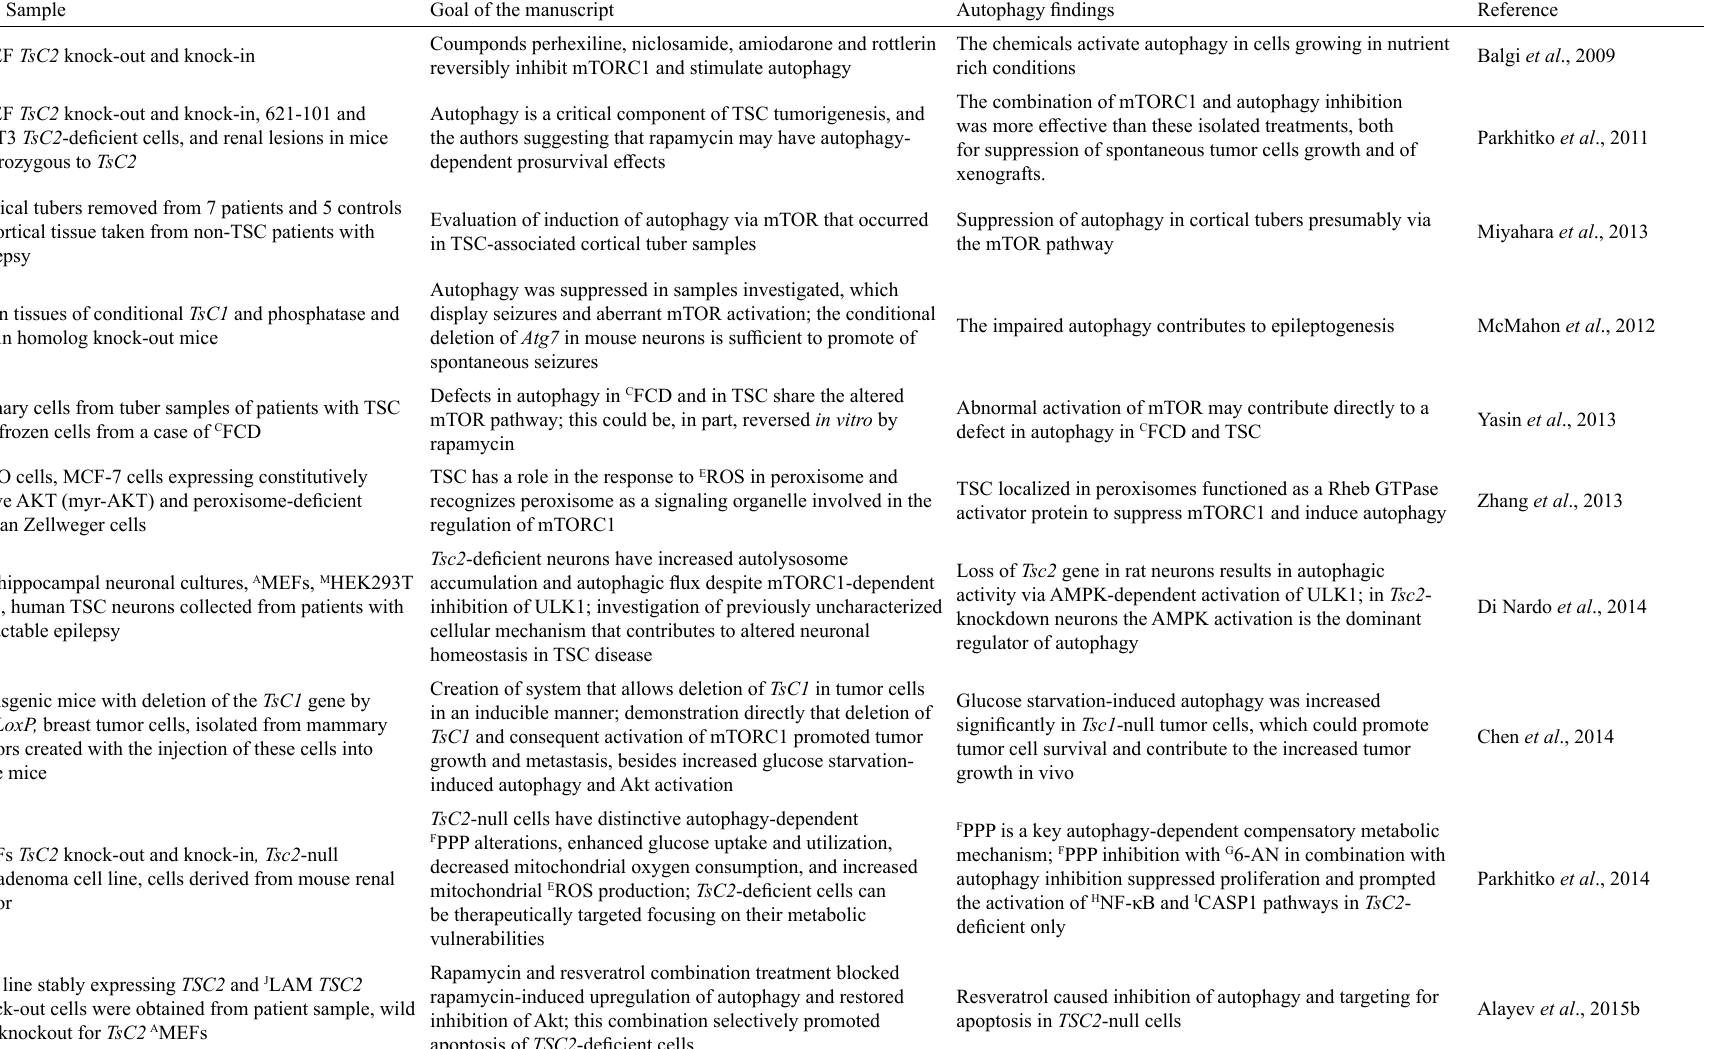
Table 1 – Original articles describing the role of autophagy in TSC